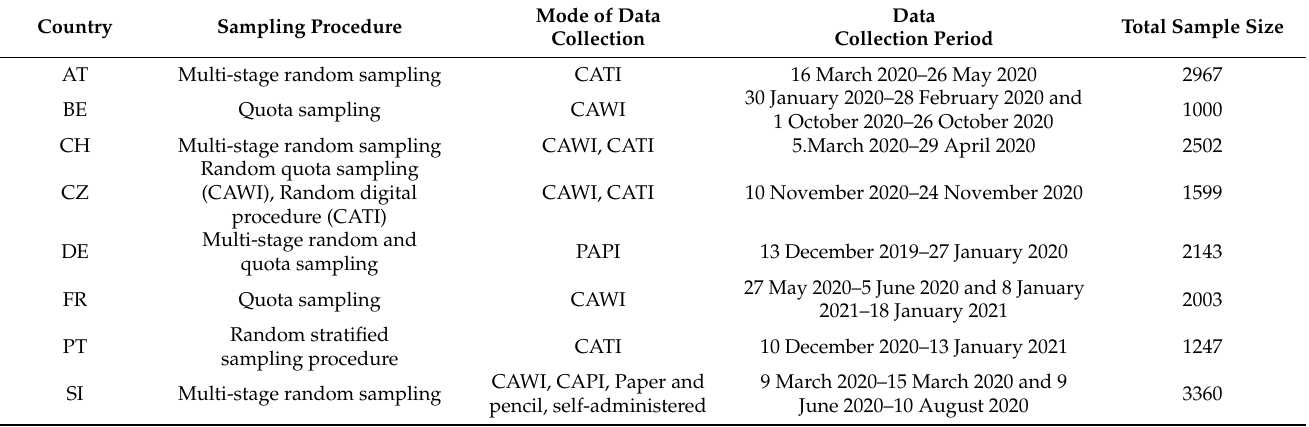
Table 2. Sampling procedure, mode, data collection period, and total sample size for the